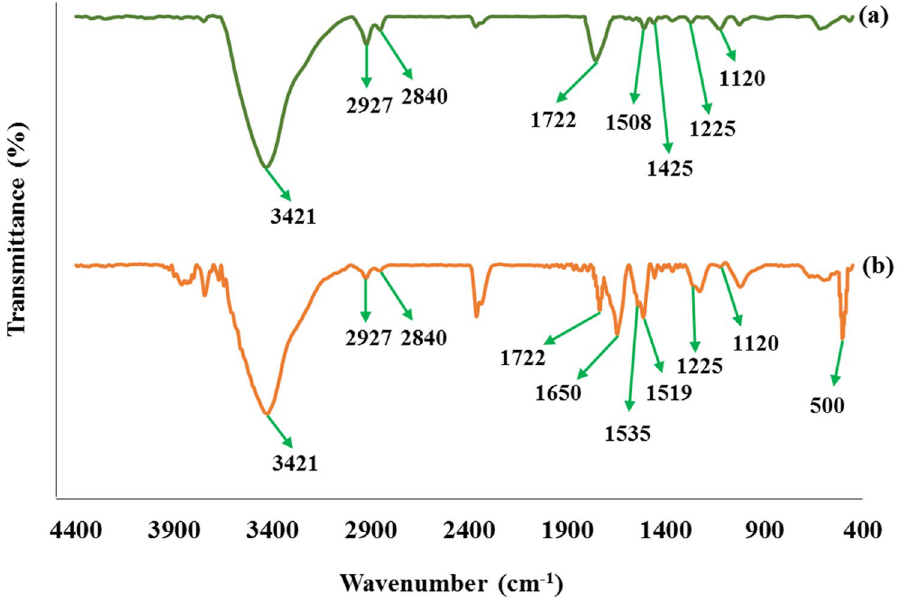
Figure 2. FT-IR spectra of ( a ) Graphene oxide-lignin and ( b ) Graphene oxide-lignin/silk fibroin/ZnO